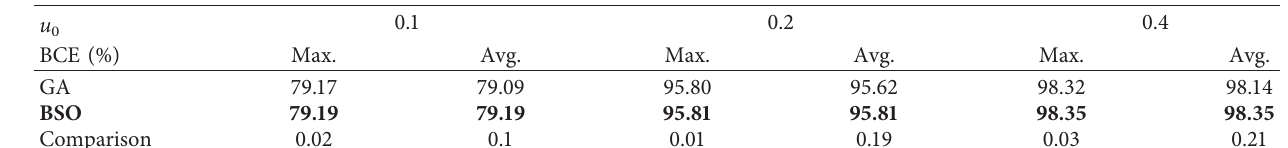
Table 2: Maximum and average BCE in BSO and GA.